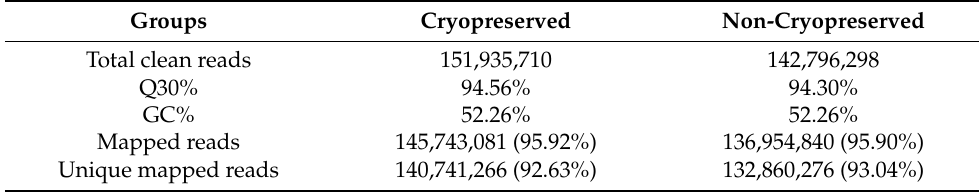
Table 1. Sequence quality and read mapping of different groups.